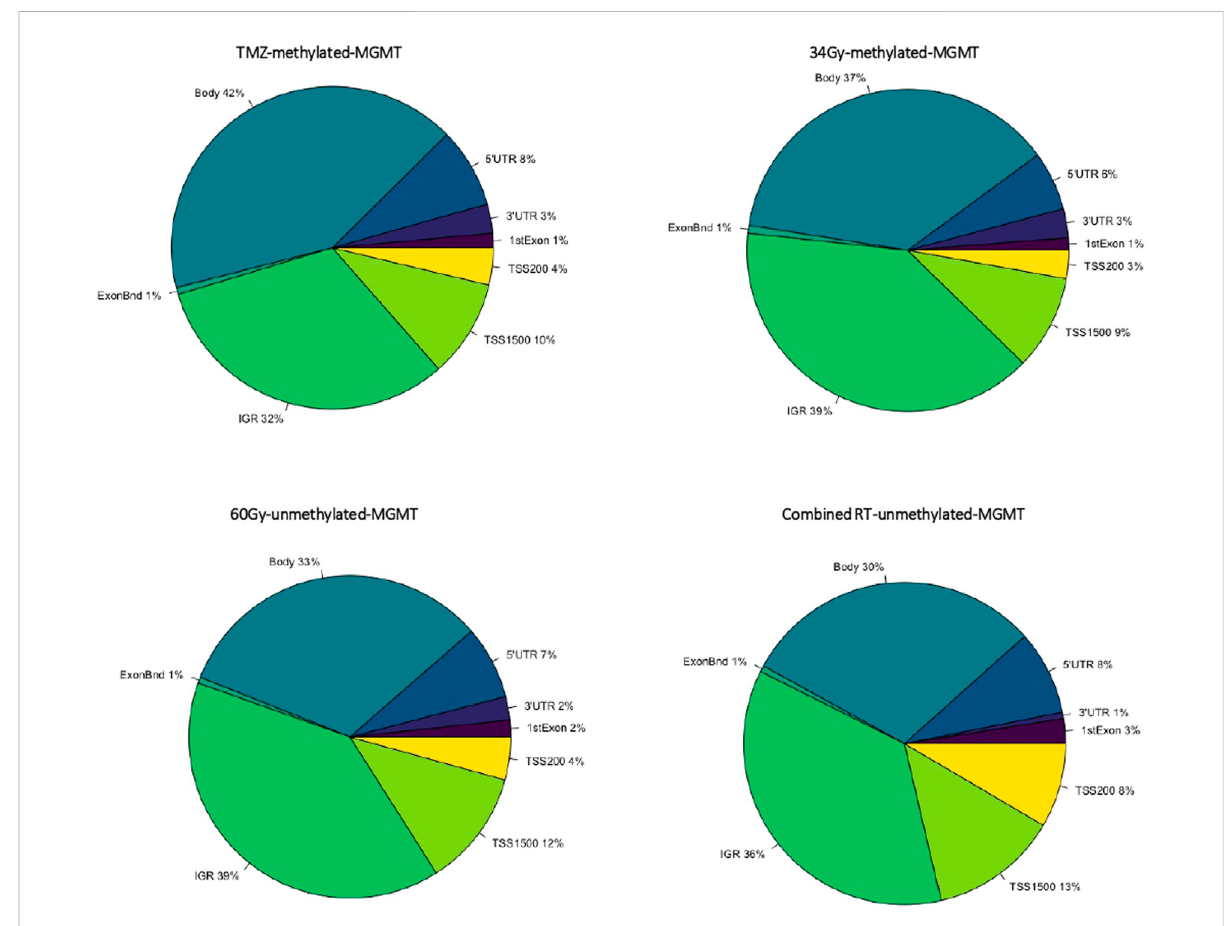
FIGURE 2 Pie charts representing the structural genomic distribution of DMCs discovered in samples with long ( n = 3) and short ( n = 3) survival within the different treatment arms and with speci fi ed MGMT promoter methylation status. TSS200, 200 bases upstream transcription start site; TSS1500, 1,500 bases upstream transcription start site; UTR, untranslated region; IGR, intergenic region; 60Gy34Gy, combined